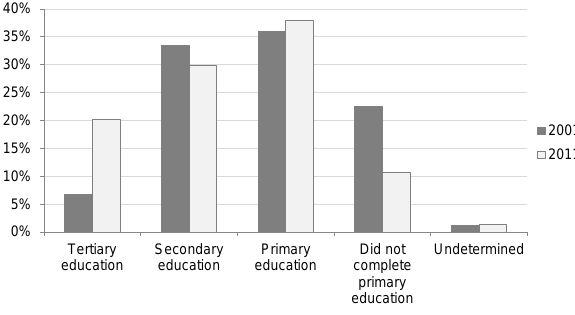
Figure 1: Labour force by level of education